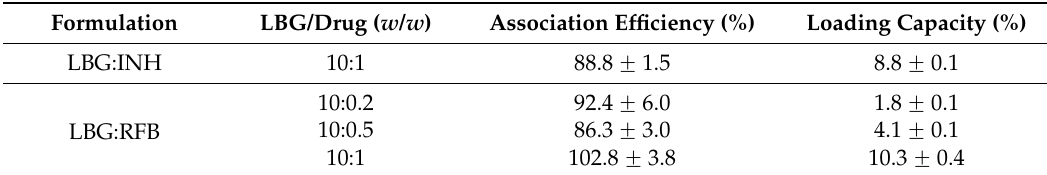
Table 3. Drug association efficiency and microparticle loading capacity determined for LBG microparticles (mean ˘ SD, n =